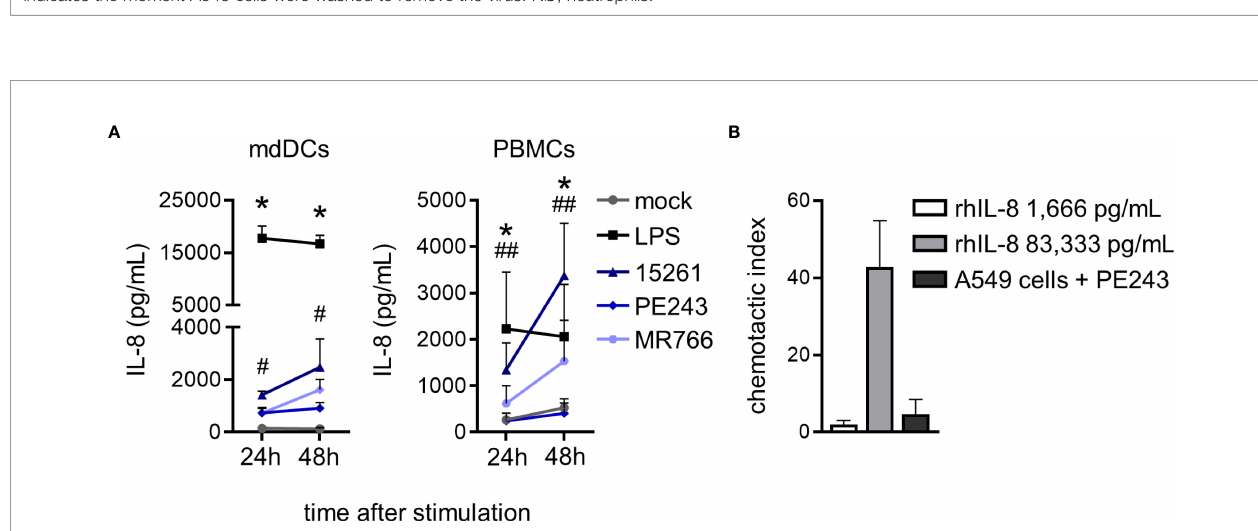
FIGURE 5 | ZIKV infection in primary human cells does not induce high levels of IL-8 to promote migration of human neutrophils. (A) IL-8 levels in mdDCs and PBMCs culture supernatant at 24 and 48 hours after stimulation with mock, LPS (100 ng/mL), or ZIKV strains (1 MOI). (B) Chemotactic index of neutrophils after 2 hours of stimulation with 1,666 or 83,333 pg/mL of rhIL-8 or the supernatant of A549 cell culture pre-infected with ZIKV PE243 for 48 hours. Bars indicate SEM. Two-three independent experiments are shown (n = 6 – 9). The asterisk (*) denotes the statistical difference between mock and LPS, and the number sign (#) represents the difference between mock and all the three ZIKV strains at the time point. Double number signs (##) denote the statistical difference between mock and ZIKV 15261 (PBMCs – 24h) and between mock, ZIKV 15261, and MR766 (PBMCs –